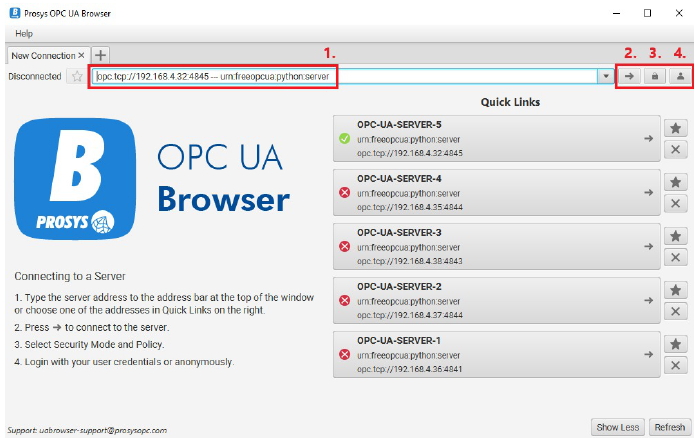
Figure 8. OPC UA browser connection setup.